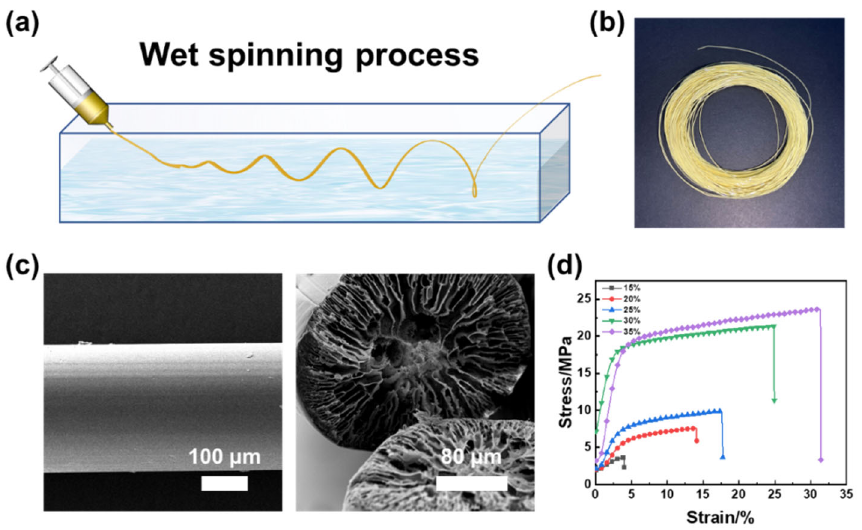
Figure 1. ( a ) The process of fabrication of PAI/BMI filaments. ( b ) PAI filaments. ( c ) The SEM images of PAI/BMI filament. ( d ) Stress ‐ strain curves of filaments with different PAI content. of PAI/BMI filament. ( d ) Stress-strain curves of filaments with different PAI